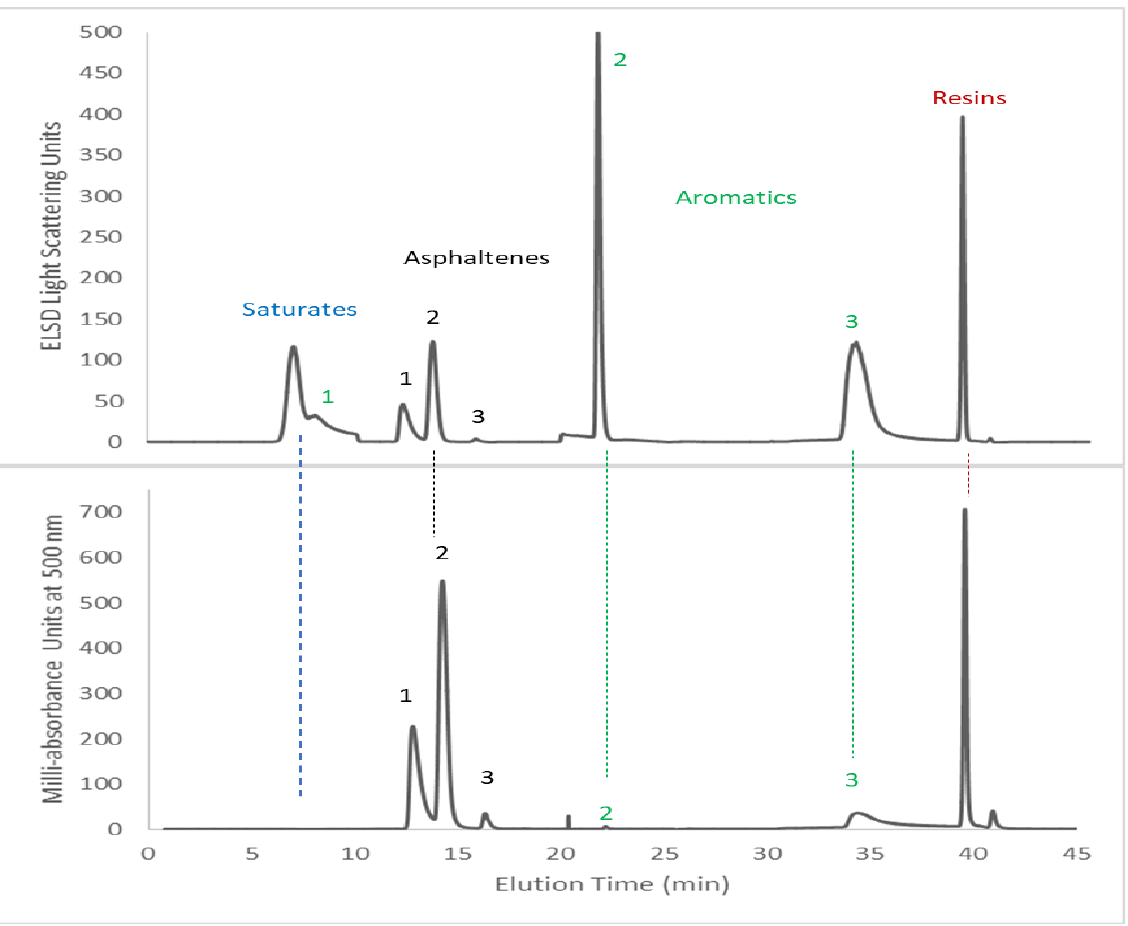
Figure 1. SAR-AD separation profiles for a Lloydminster vacuum residue. Asphaltene 1 = CyC 6 , asphaltene 2 = Toluene, and Asphaltene 3 = CH 2 Cl 2 . (The different colors designate Saturates — blue; Asphaltenes — black; Aromatics — green; Resins — red.)